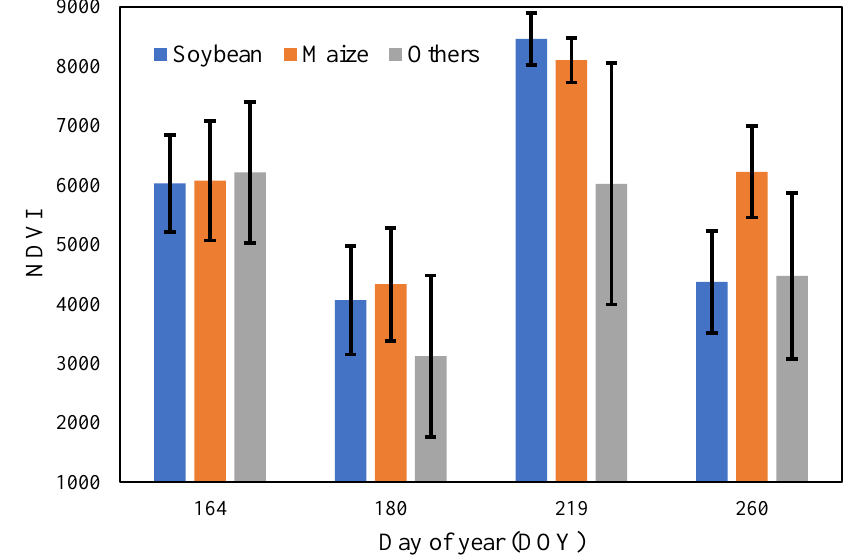
Figure 8. The mean and standard deviations of NDVI of soybean, maize, and others at different growing stage.